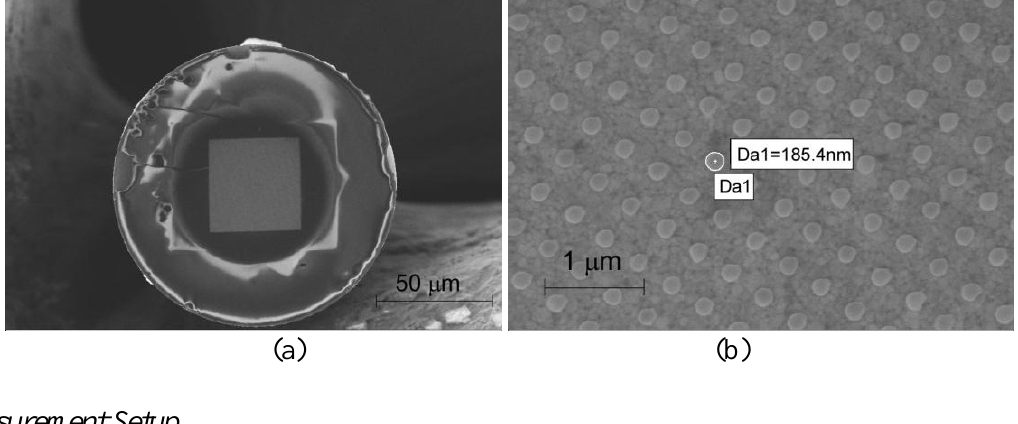
Figure 2. Scanning electron micrographs of a gold nanodot array on an optical fiber tip. (a) Overview of the optical fiber end facet, and (b) gold nanodot array on the optical fiber facet.